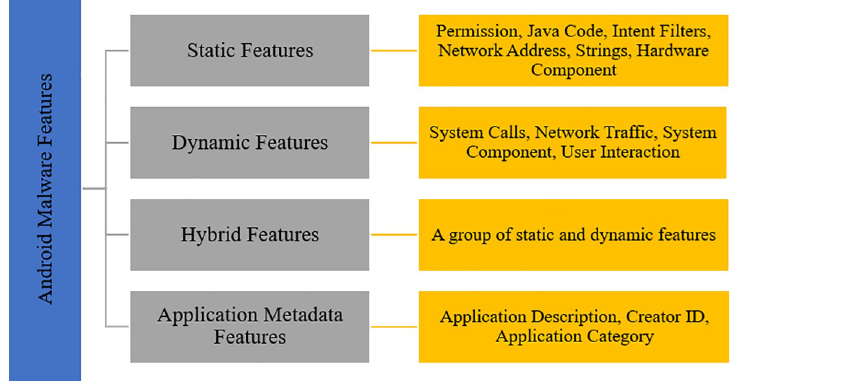
Fig 4. Taxonomy of Android malware